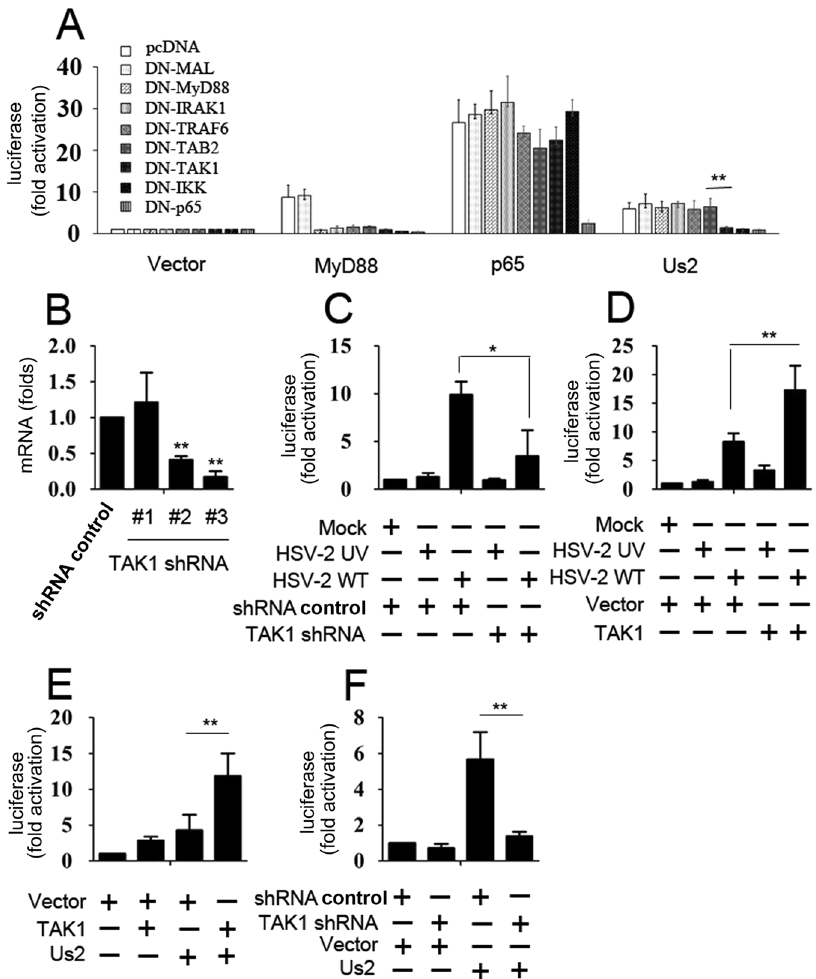
Figure 2. Identification of cellular signaling molecules needed for NF- κ B activation by Us2. ( A ) 293 T cells were co-transfected with NF- κ B-luc and dominant-negative mutant forms of MAL, MyD88, IRAK1, TRAF6, TAK1, TAB2, IKK, or p65 for 24 h prior to luciferase assays. ( B ) End1/E6E7 cells were transfected with the indicated TAK1 shRNAs for 48 h prior to real-time RT-PCR analyses. ( C ) End1/E6E7 cells NF- κ B-luc and TAK1 shRNA or shRNA control for 12 h, and infected with the indicated viruses for 12 h prior to luciferase assays. ( D ) Experiments were performed as in C except that cells were transfected with pCMV-TAK1 or control vector. ( E and F ) 293 T cells were co-transfected with NF- κ B-luc and the indicated plasmids for 12 h prior to luciferase assays. The results are the mean ± SD of triplicate cultures, representing three independent experiments ( * P < 0.05, ** P <